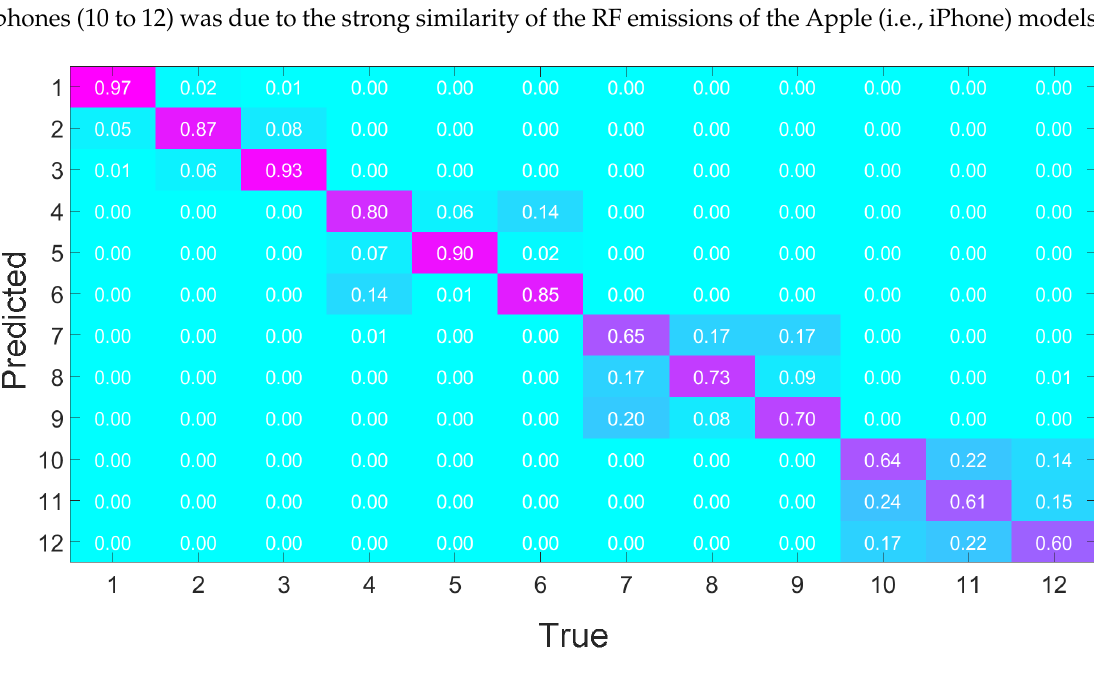
Figure 9. Confusion matrix for WSST calculated with the KNN machine learning algorithm with K = 1 at SNR = 50